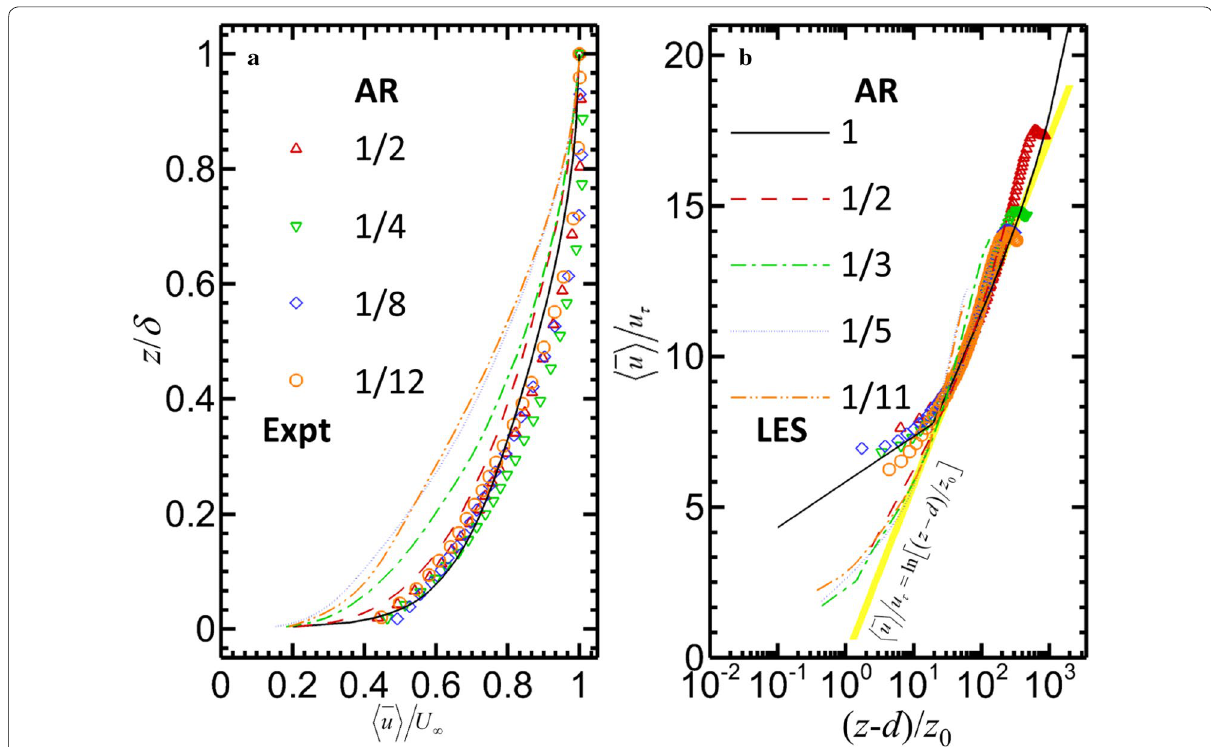
Fig. 3 Dimensionless mean‑wind‑speed (cid:31) u (cid:30) profiles plotted as functions of wall‑normal distance z in: a linear and b logarithmic